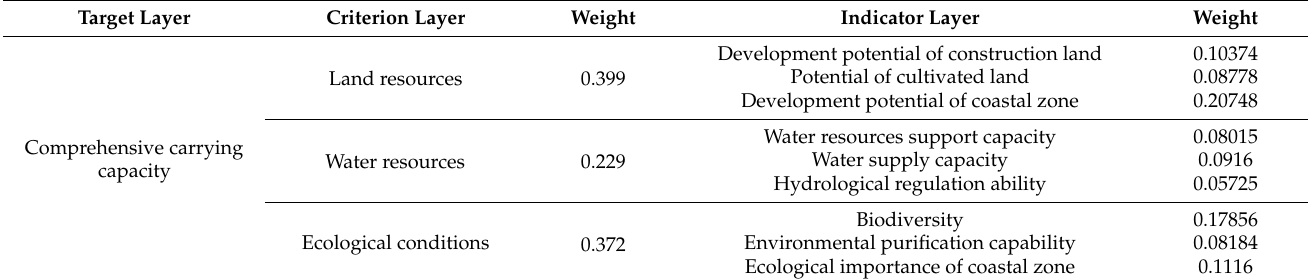
Table 4. Weights of each indicator for comprehensive carrying capacity.